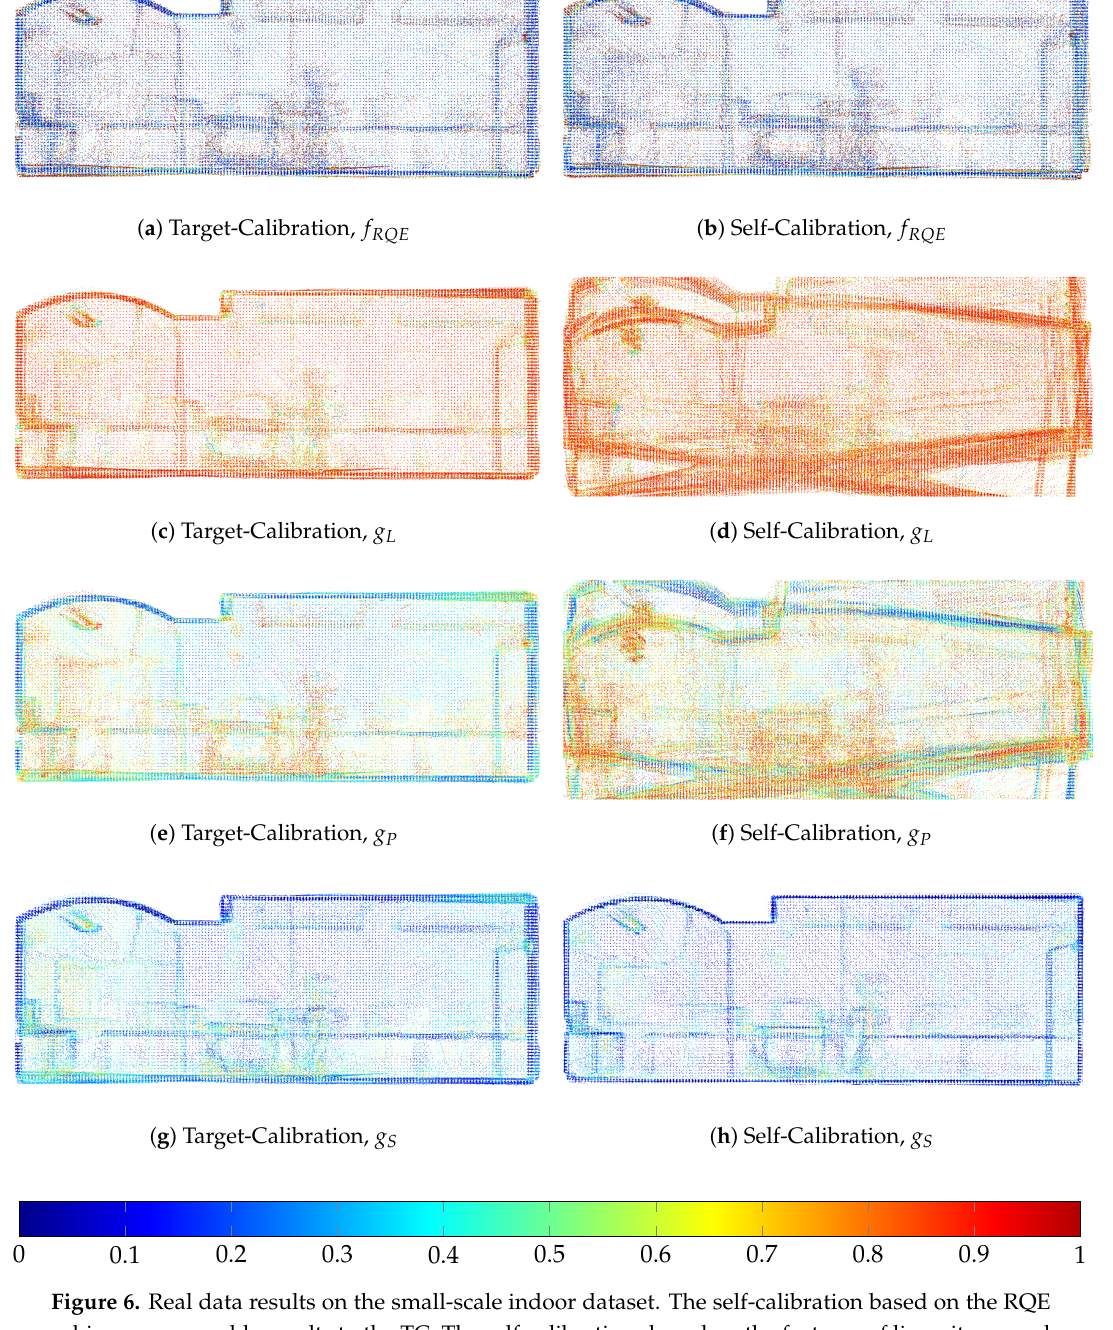
Figure 6. Real data results on the small-scale indoor dataset. The self-calibration based on the RQE achieves comparable results to the TC. The self-calibrations based on the features of linearity g L and planarity g P failed. The self-calibration based on the feature of sphericity g S , however, results in a sharper point cloud than the target